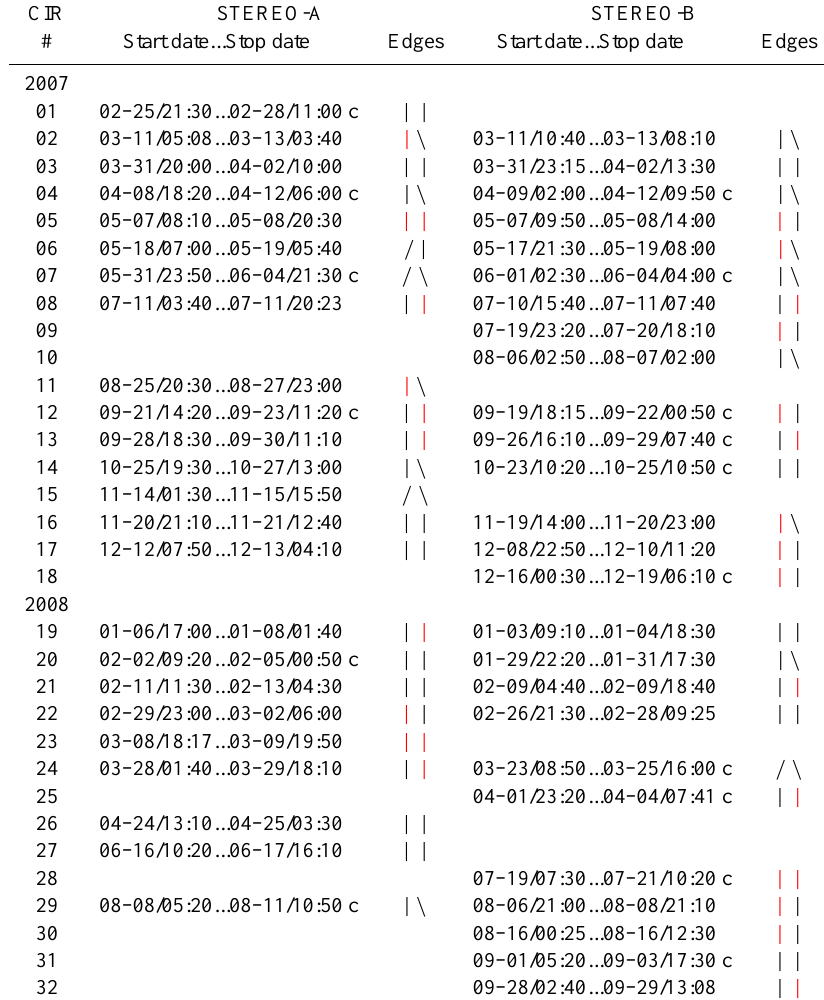
Table 1. Time intervals and type of edges of CIRs included in this study. CIR STEREO-A STEREO-B Start date...Stop date Edges Start date...Stop